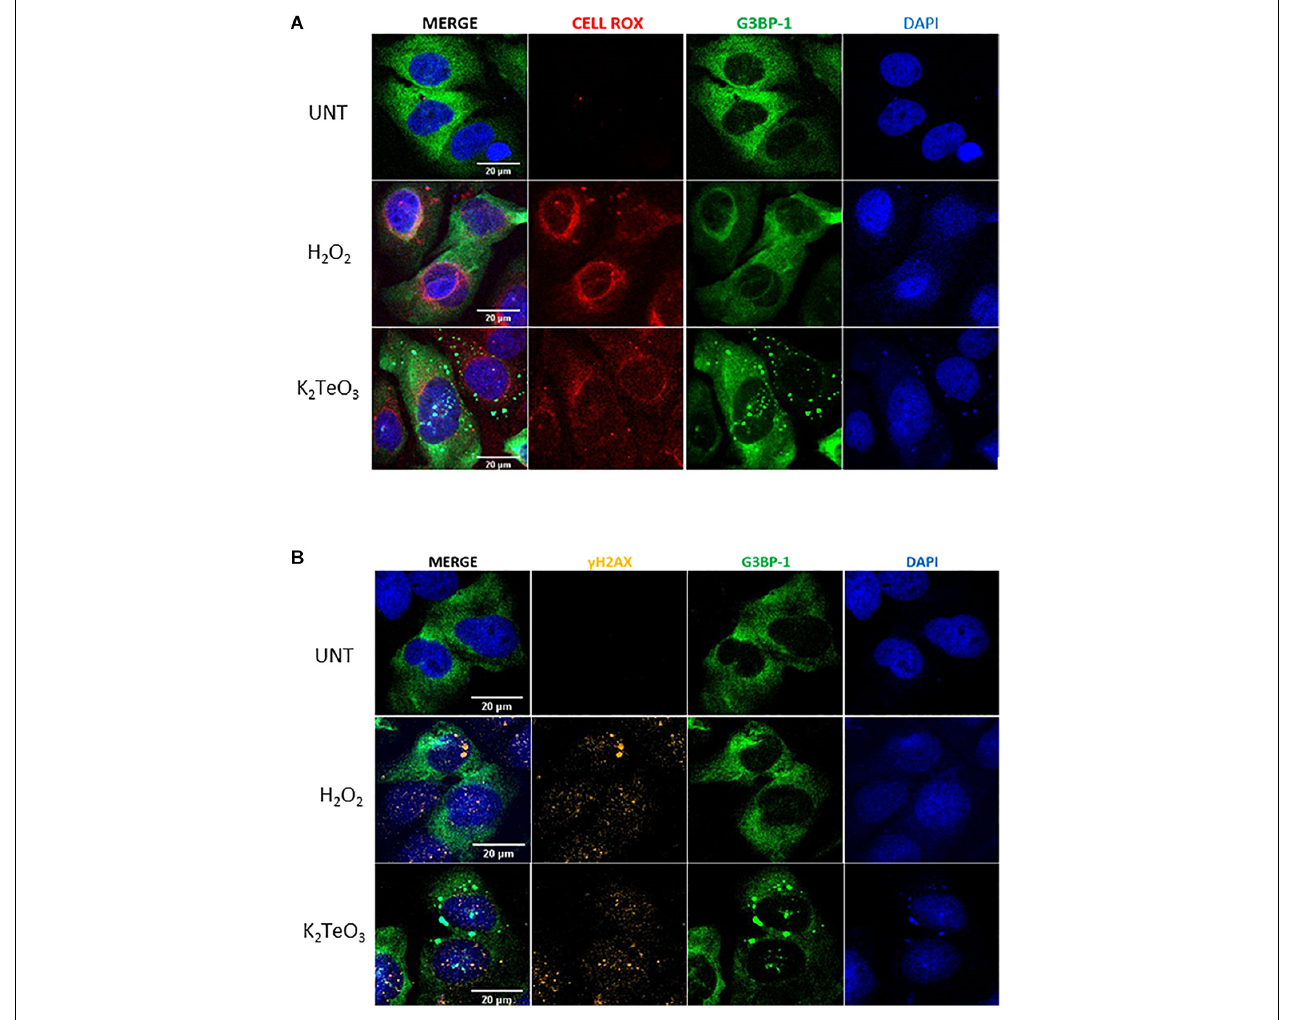
FIGURE 5 | Tellurite induces oxidative stress and DNA damage. U2OS GFP-G3BP-1 cells were treated with 50 nM H 2 O 2 for 30 min as a positive control or with 0.6 mM tellurite (K 2 TeO 3 ) for 3 h followed by incubation with a fluorogenic probe (red) to detect ROS presence (A) or immunostained with the anti- γ H2AX antibody (yellow) (B) . Nuclei were stained with DAPI (blue). Images are representative from 2 independent